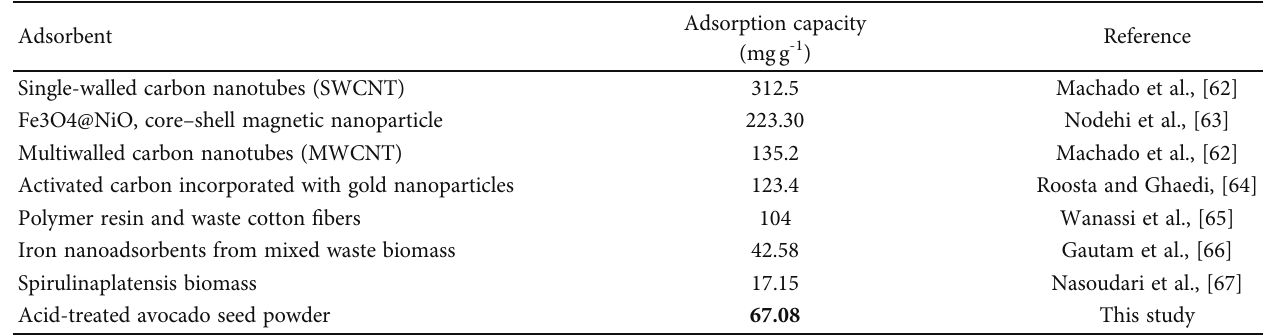
Table 4: Comparison of CTASP ’ s adsorption capability with already available